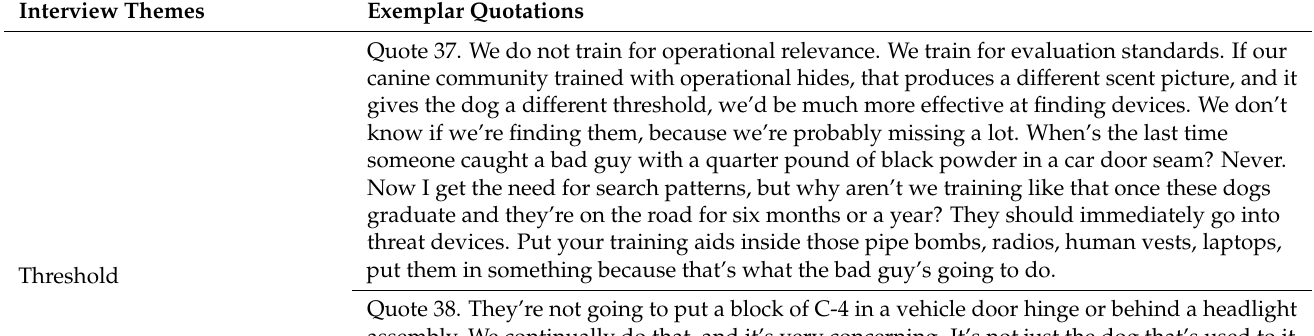
Table 8. Explosive odor environmental factor themes and exemplar